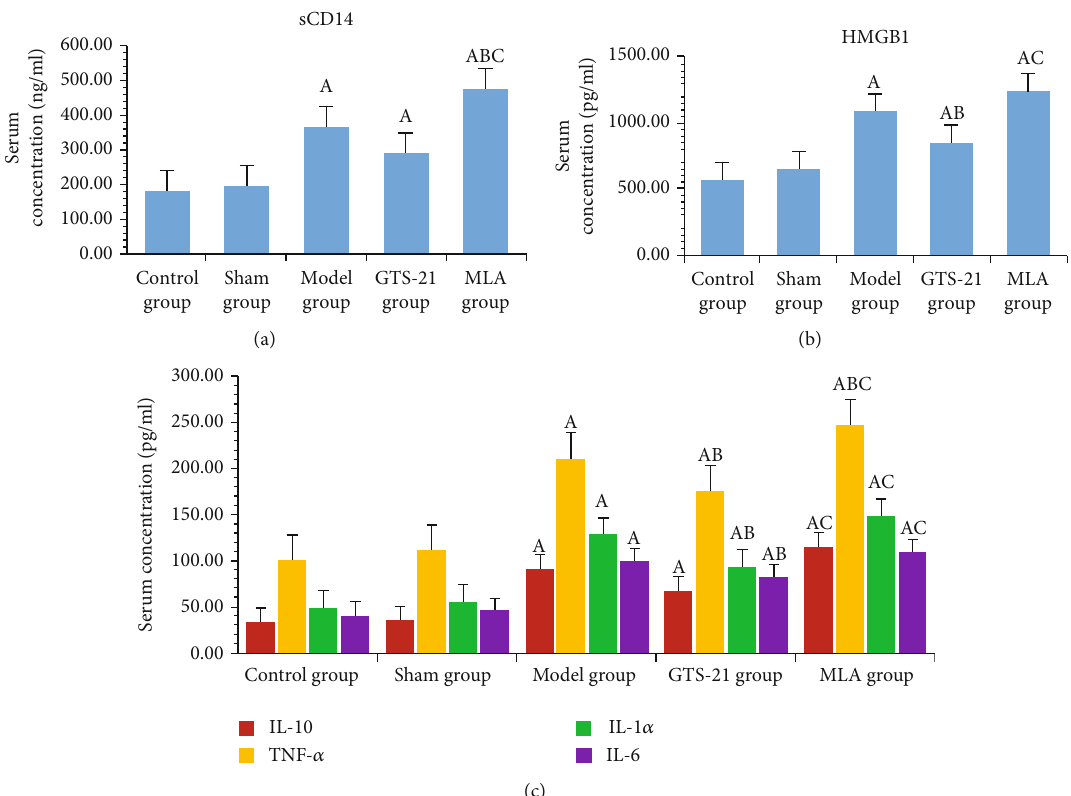
Figure 3: The concentration of serum proin fl ammatory cytokines among the groups of rats. sCD14: soluble CD14; precepsin; HMGB-1: high mobility group box-1; IL-10: interleukin 10; TNF- α : tumor necrosis factor alpha; IL-1 α : interleukin 1 alpha; IL-6: interleukin 6. (a) The serum sCD14 concentration (ng/mL) among di ff erent groups; it is a marker of in fl ammation in the late stage of sepsis. (c) Serum concentration of IL- 10, TNF- α , IL-1 α , and IL-6 (pg/mL) among groups. The serum sCD14 levels of the model group, GTS-21 group, and MLA group were much higher than those of the control group. The P value and 95% CI were, respectively, 0.000, -286.858 ∼ -79.4662; 0.44, -209.616 ∼ -2.223; and 0.000, 400.647 ∼ -193.255, and so were HMGB1, TNF- α , IL-10, and IL-6. For HMGB1, they were 0.000, -766.215 ∼ -289.627; 0.012, -527.403 ∼ -50.815; and 0.000, -917.862 ∼ -441.275. For TNF- α , they were 0.000, -139.923 ∼ -82.198; 0.000, -104.224 ∼ -46.494; and 0.000, 175.466. For IL-1 α , they were 0.000, -102.305 ∼ -57.714; 0.000, -66.369 ∼ -21.777; and 0.000, -121.697 ∼ -77.106. For IL-10, they were 0.000, -83.572 ∼ -32.005; 0.006, -59.758 ∼ -8.191; and 0.000, -108.319 ∼ -56.752. For IL-6, they were 0.000, -77.851 ∼ -42.647; 0.000-59.996 ∼ -24.792; and 0.000, -87.186 ∼ -51.982. The serum sCD14, HMGB1, TNF- α , IL-1 α , IL-10, and IL-6 levels of the MLA group were much higher than those of rats in the GTS-21 group; the P value and 95% CI were, respectively, 0.000, -294.727 ∼ -87.3357; 0.001, 152.166 ∼ 628.754; 0.000, 42.107 ∼ 99.837; 0.000, 33.033 ∼ 77.624; 0.000, 22.777 ∼ 74.344; and 0.001, 9.588 ∼ 44.792. A: P < 0 : 05 vs. control group; B: P < 0 : 05 vs. model group; C: P < 0 : 05 vs. GTS-21